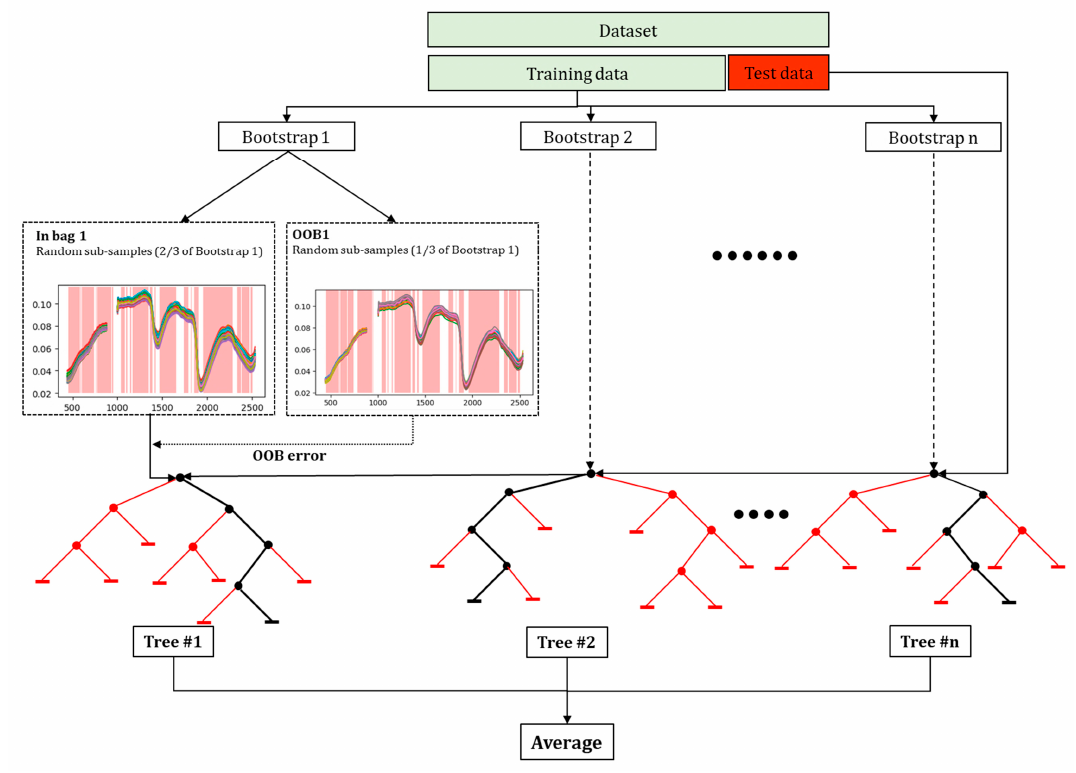
Figure 2. Schematic of the random forest regression model.